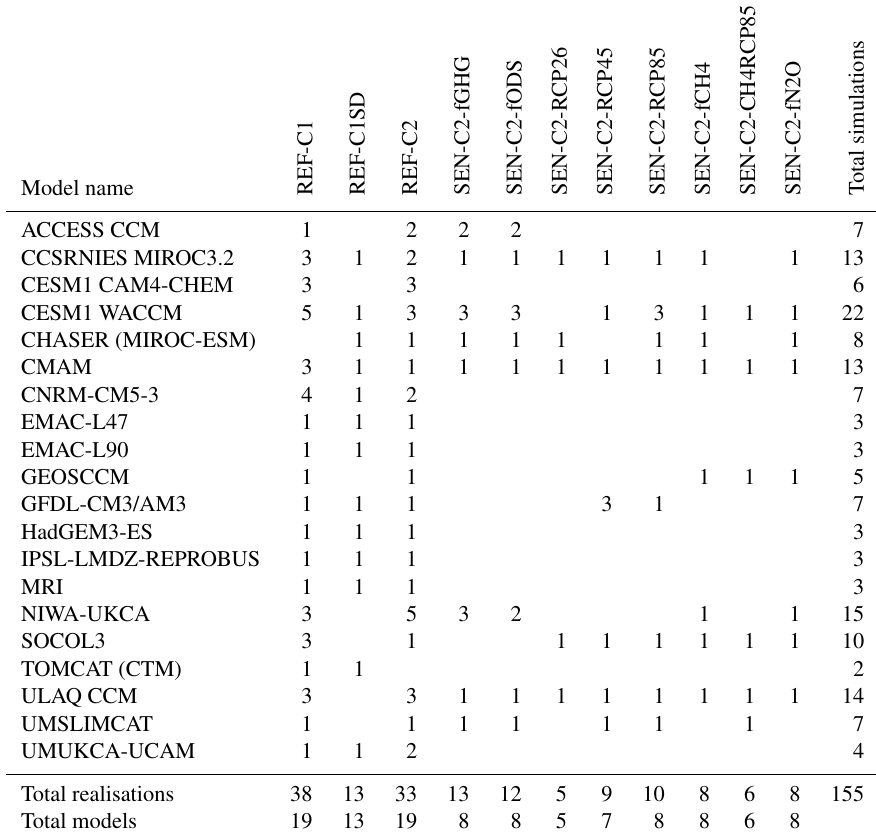
Table 2. CCMI simulations analysed in this study. The numbers indicate the number of realisations by each model for each